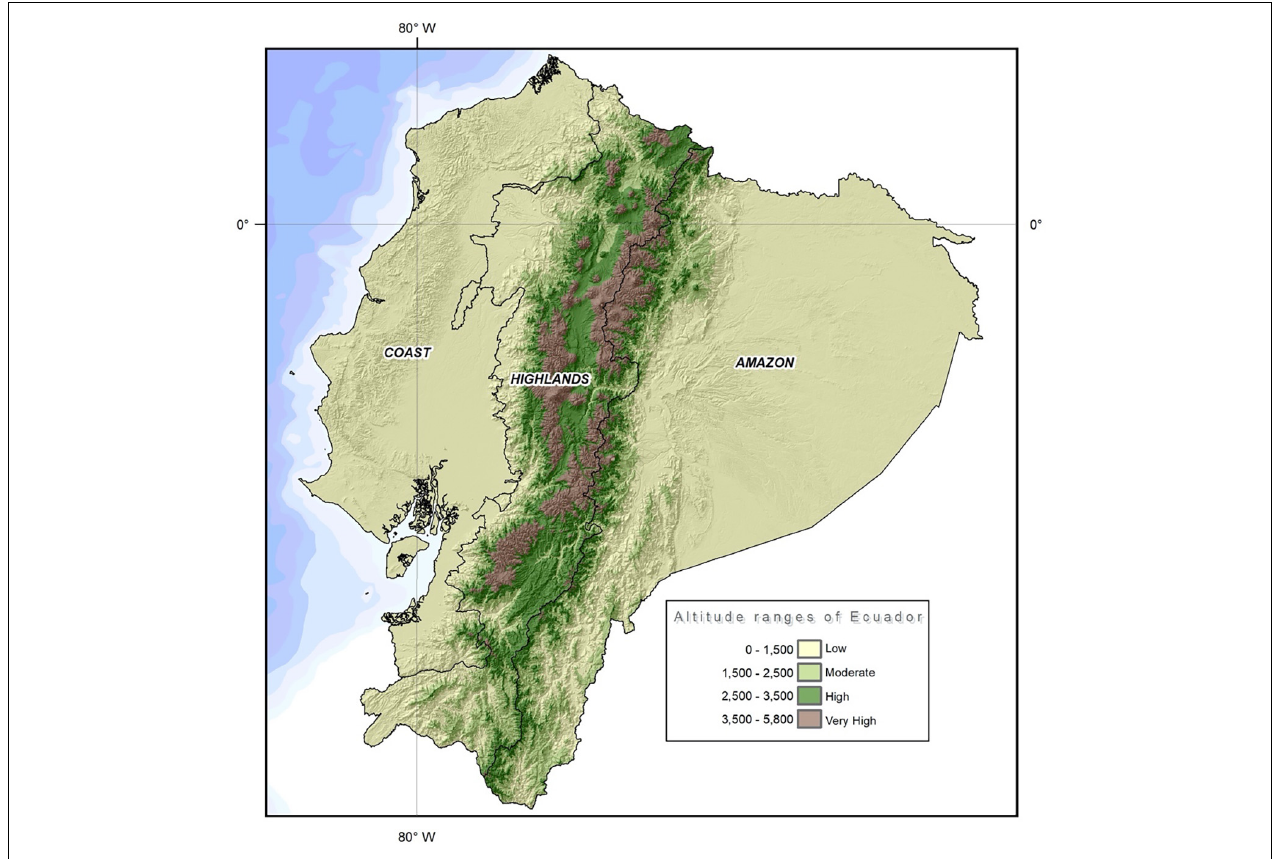
FIGURE 1 | Topographic map of Ecuador using elevation contour lines to show the shape of the country’s surface. Map created by the